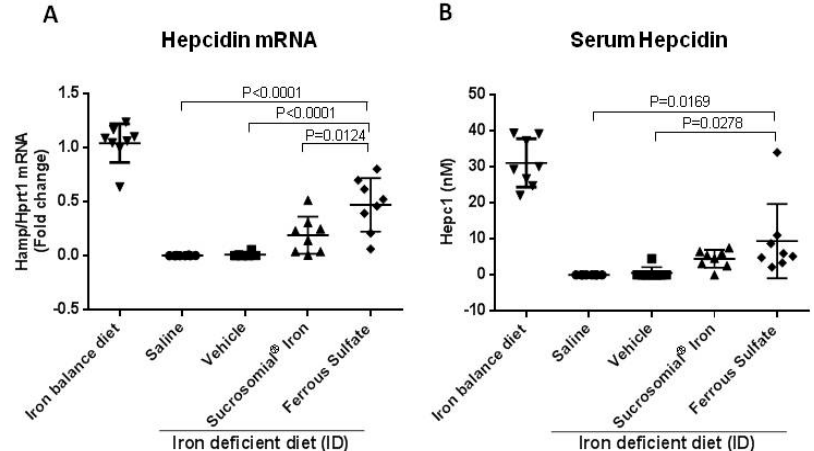
Figure 4. Treatment effect on liver hepcidin mRNA and serum hepcidin. ( A ) qPCR for hepcidin normalized for HPRT1; and ( B ) serum hepcidin by mass spectrometry. Analysis by qPCR were performed on samples derived from liver of healthy untreated mice on an iron balanced diet (IB) and mice on iron deficient diet (ID) treated with Saline, Vehicle, Sucrosomial ® Iron and Ferrous Sulfate (1 mg/kg) by gavage for two weeks. In ( A ) and ( B ) Saline (circles), Vehicle (squares), Sucrosomial ® Iron (triangles), Ferrous Sulfate (diamonds) and iron balance group (inverted triangles). p values were obtained by one-way